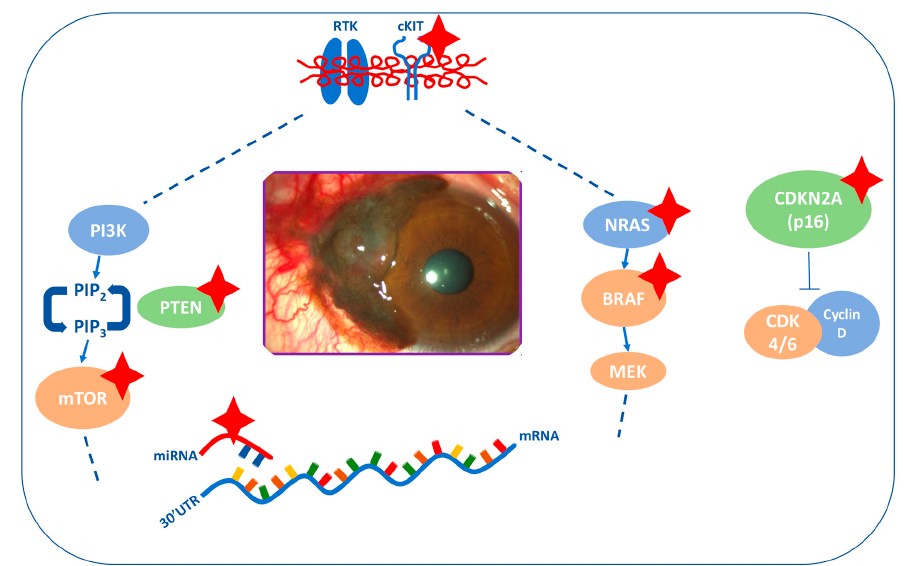
2. Figure 2. Main mechanisms involved in conjunctival melanoma (CjM). The most relevant alterations are indicated with red stars. BRAF and NRAS mutations are mutually exclusive. cKIT mutations are mutually exclusive with BRAF / NRAS